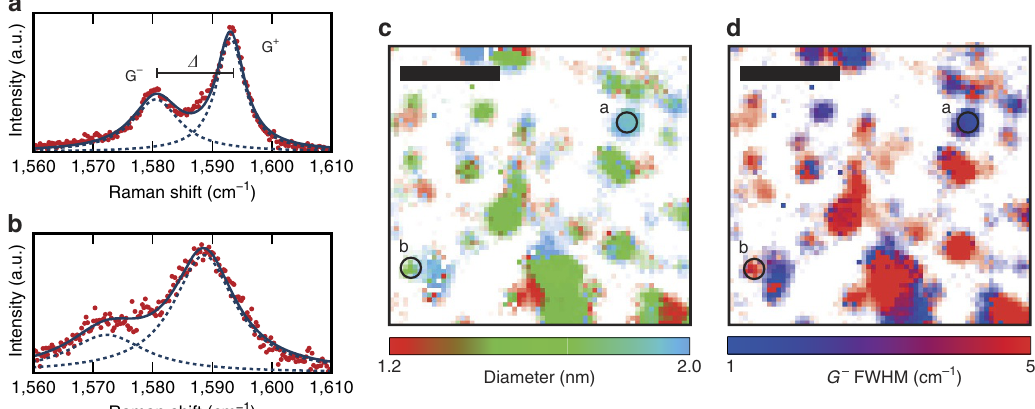
Figure 4 | Mapping of CNT diameter and electronic structure using cavity-enhanced hyperspectral imaging. Example of cavity-enhanced G-band spectra for a semiconducting ( a ) and a metallic ( b ) nanotube, taken at the location of the circles shown in c and d . The solid line is a sum of two Lorentzians fitted to the data and the dashed lines are the underlying individual Lorentzians of the G (cid:2) and G þ lines, respectively. ( c ) Spatial map of the evaluated tube diameter from the G þ /G (cid:2) line splitting measured on the same area as shown in Fig. 3a. An average diameter of 1.5nm is observed, in good agreement with atomic force microscopy. ( d ) Spatial map of the evaluated G (cid:2) linewidth (full width at half maximum, FWHM). Broad lines are expected for metallic nanotubes, while semiconducting nanotubes typically show narrow lines. Scale bars, 10 m